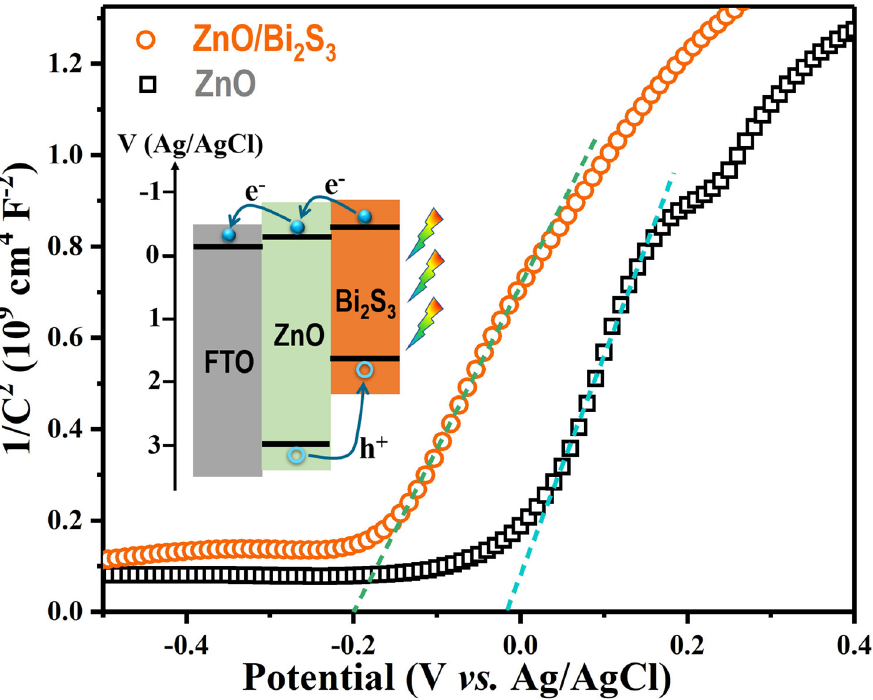
Figure 8. Mott–Schottky plots of ZnO and ZnO/Bi 2 S 3 photoanodes under dark. The inset is the schematic diagram of energy band alignments.